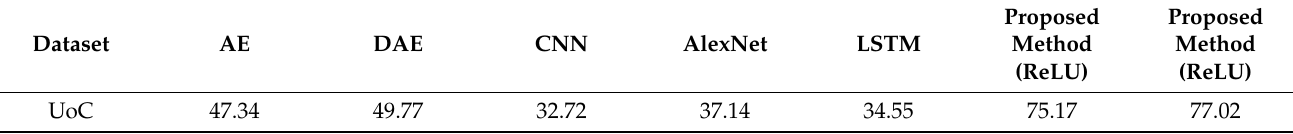
Table 5. Accuracy (%) for methods in UoC